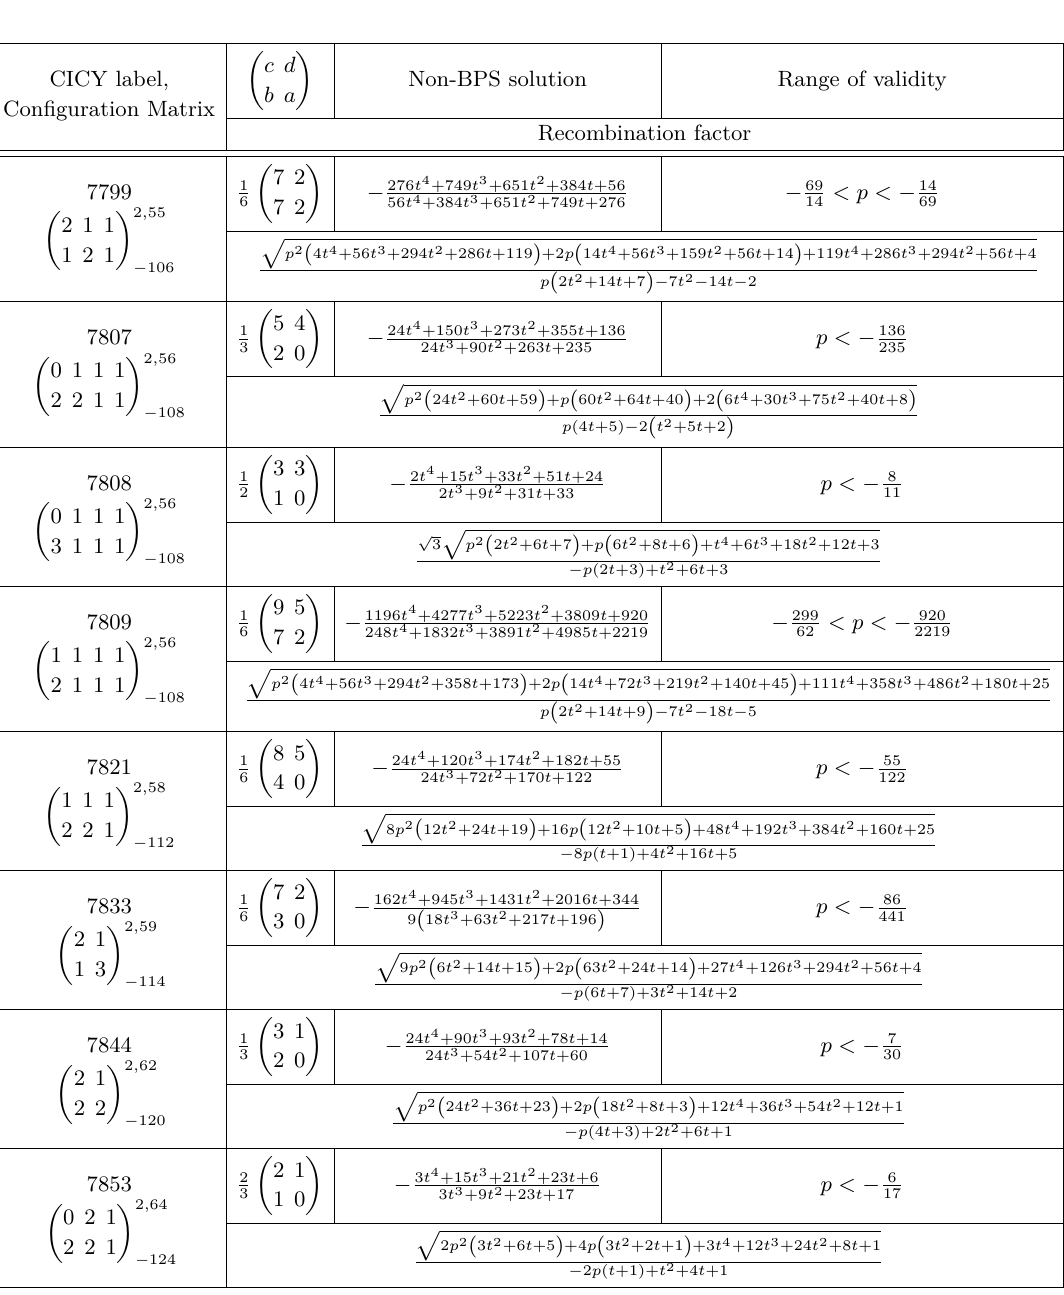
Table 10 . Non-BPS extremal black strings in one-modulus CICY models,